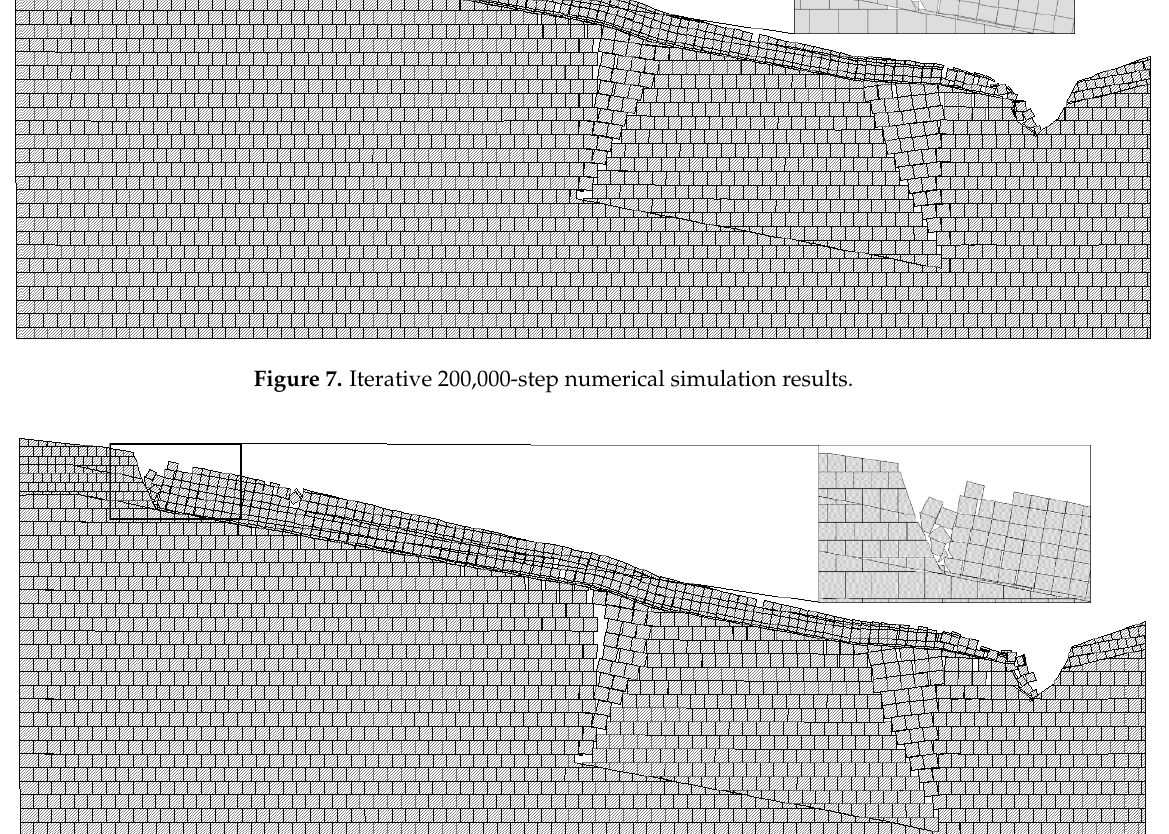
Figure 7. Iterative 200,000-step numerical simulation results.